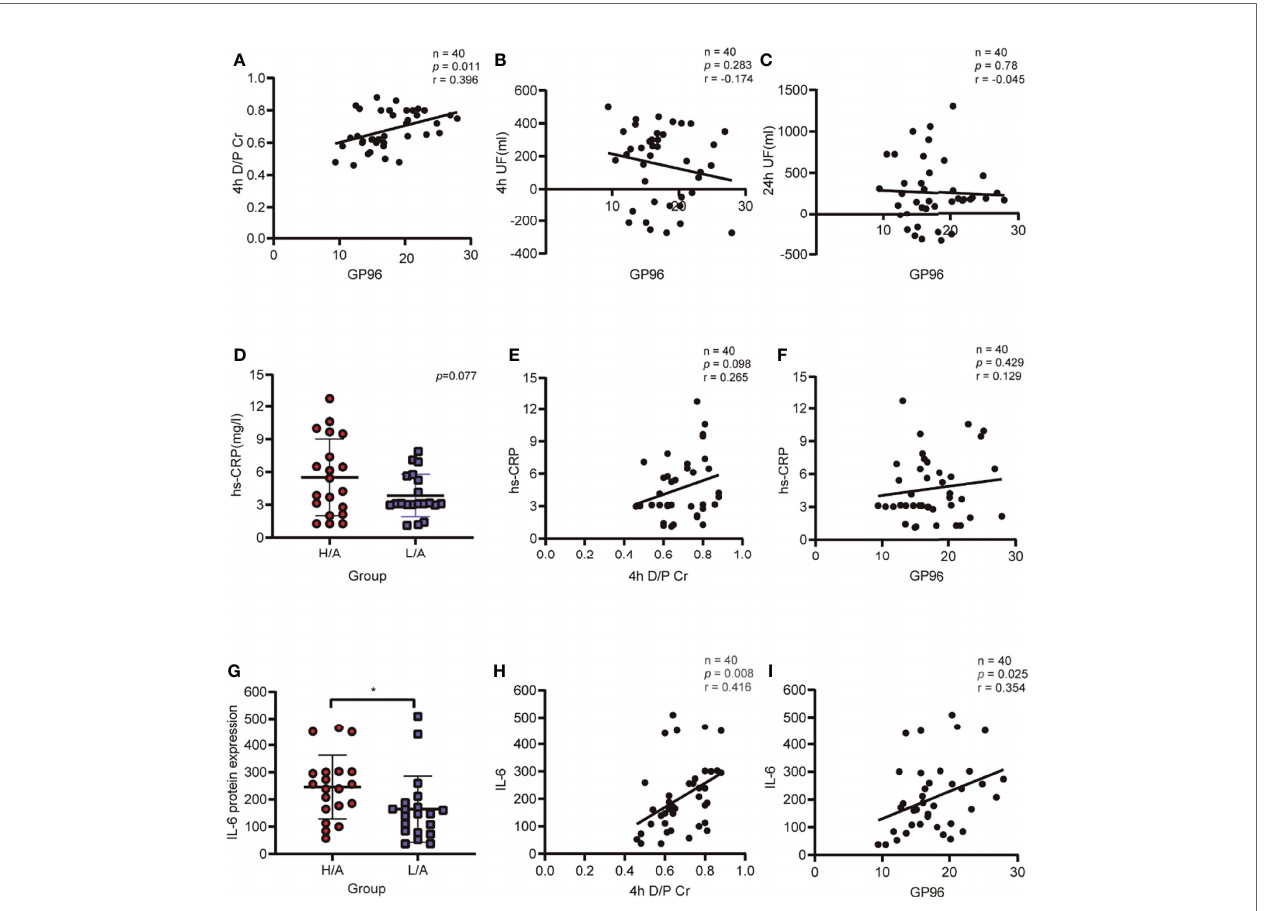
FIGURE 5 | Correlation of PDE-EVs-GP96 with ultra fi ltration (UF), the dialysate-to-plasma ratios of creatinine (D/P Cr ), and in fl ammatory indicators. (A) PDE-EVs- GP96 positively correlated with 4h D/P Cr . (B, C) Relationship between PDE-EVs-GP96 levels and 4h UF or 24h UF. (D) Different levels of serum hs-CRP in the H/A and the L/A group. (E, F) Relationship between serum hs-CRP levels and 4h D/P Cr or PDE-EVs-GP96 levels. (G) Different levels of dialysate IL-6 in the H/A and the L/A group. (H, I) Dialysate IL-6 levels positively correlated with 4h D/P Cr or PDE-EVs-GP96 levels. All data are presented as means ± SEM. Statistical analysis was